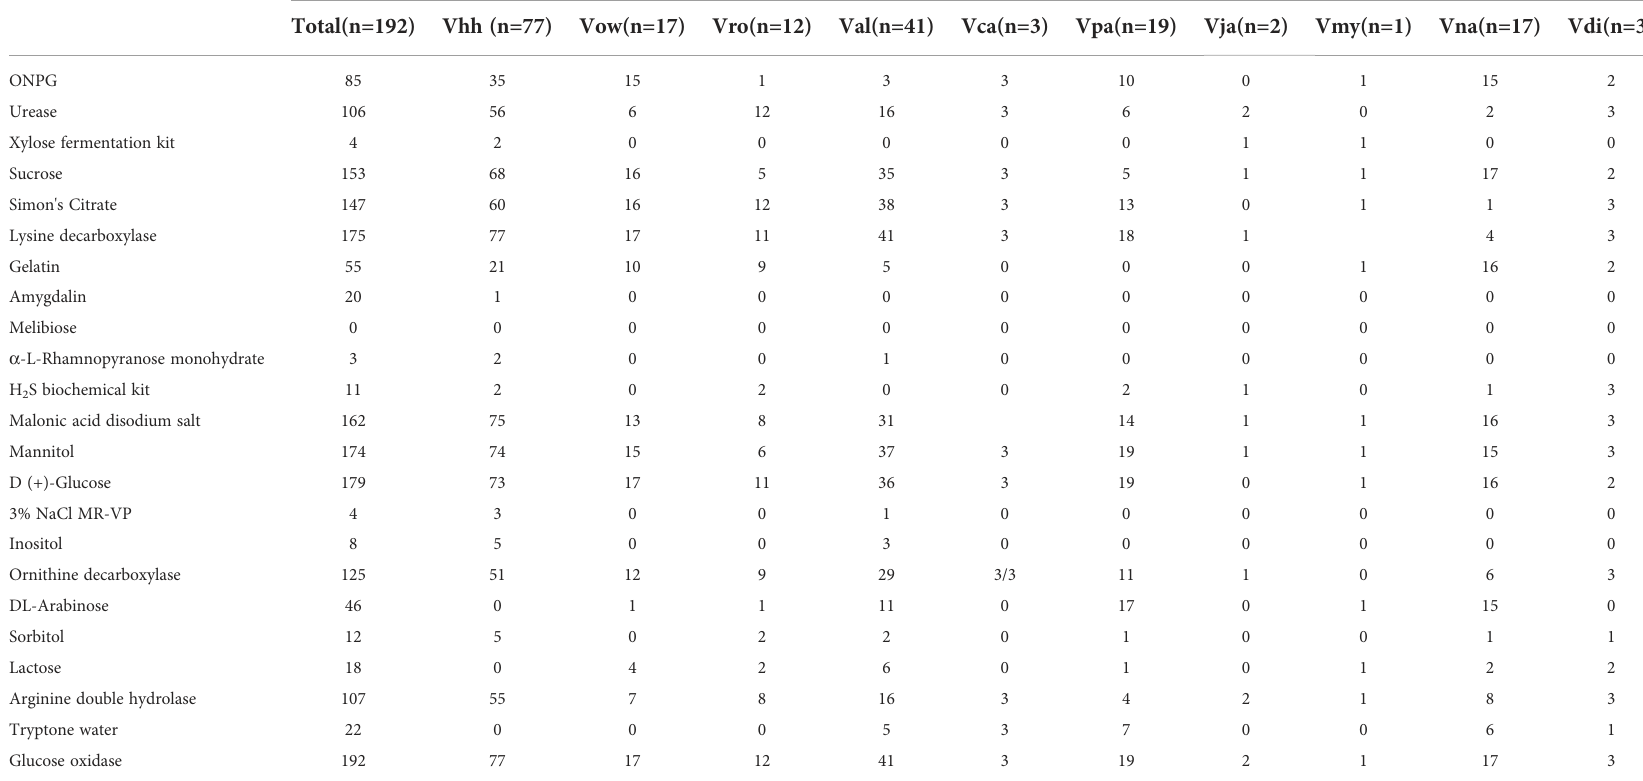
TABLE 2 Results of Harveyi clade isolates based on biochemical tests. Biochemical